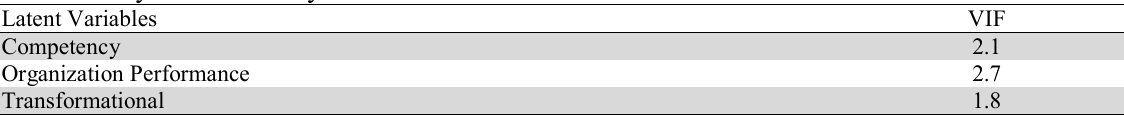
The Summary of Collinearity